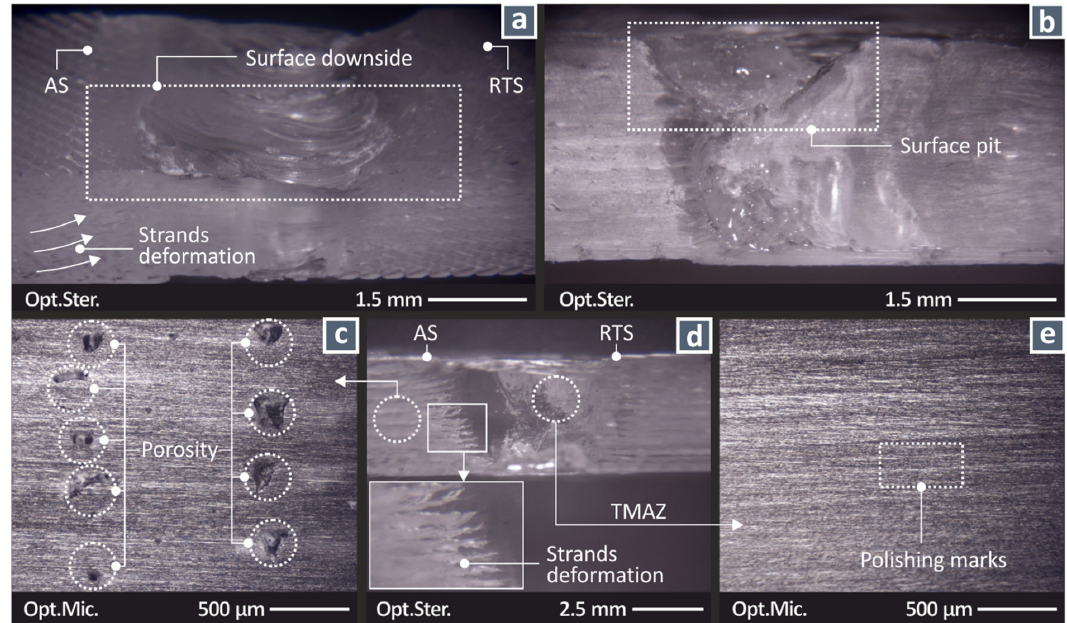
Figure 5. Views of the welded specimens’ side (vertical) surface (the weld tool performs the weld on the top surface): ( a ) HAZ stereoscopic image (1000 rpm, 6 mm/min, PPA); ( b ) HAZ stereoscopic image (1400 rpm, 6 mm/min, PPA). Specimen welded at 1000 rpm, 3 mm/min, PPA: ( c ) view outside the welding zone, ( d ) stereoscopic image, and ( e ) view of the welding zone (AS: advancing side, RTS: retreating side, TMAZ: thermomechanically affected zone).